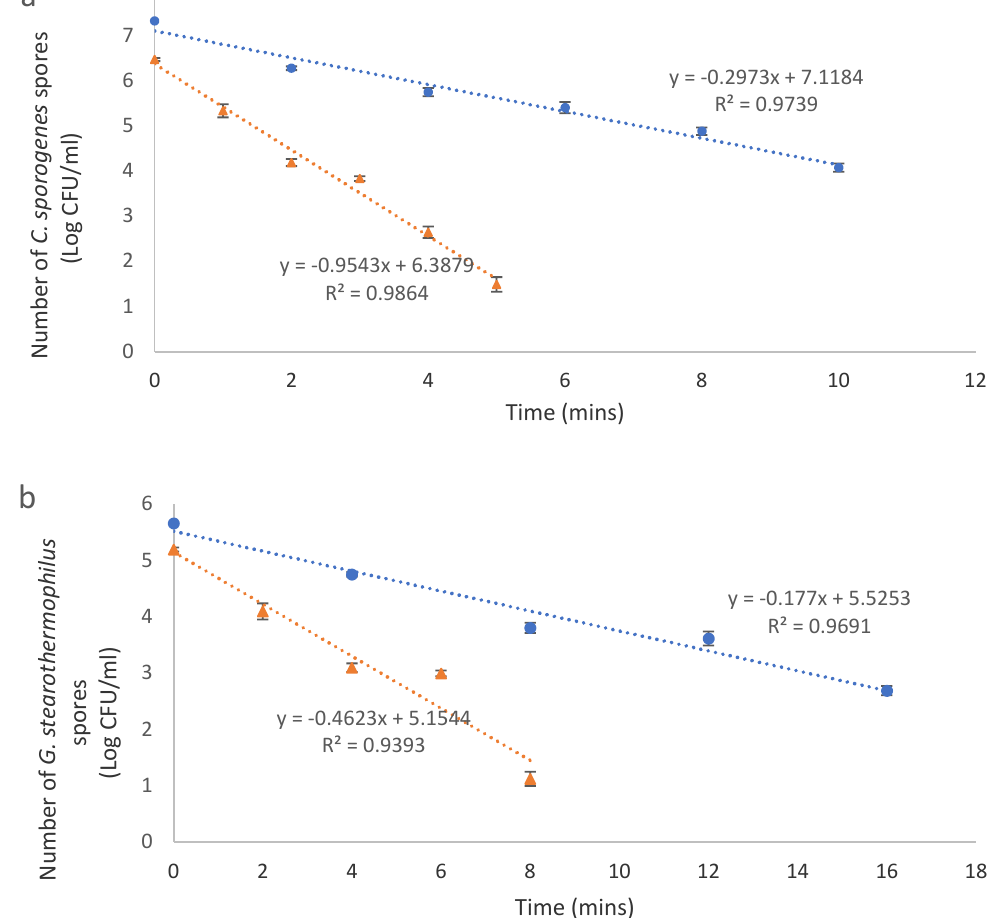
Figure 4. D121 °C values of C. sporogenes ( a ) and G. stearothermophilus ( b ) spores in autoclaved Milli Q water (triangles) and mashed potato food model (dots).